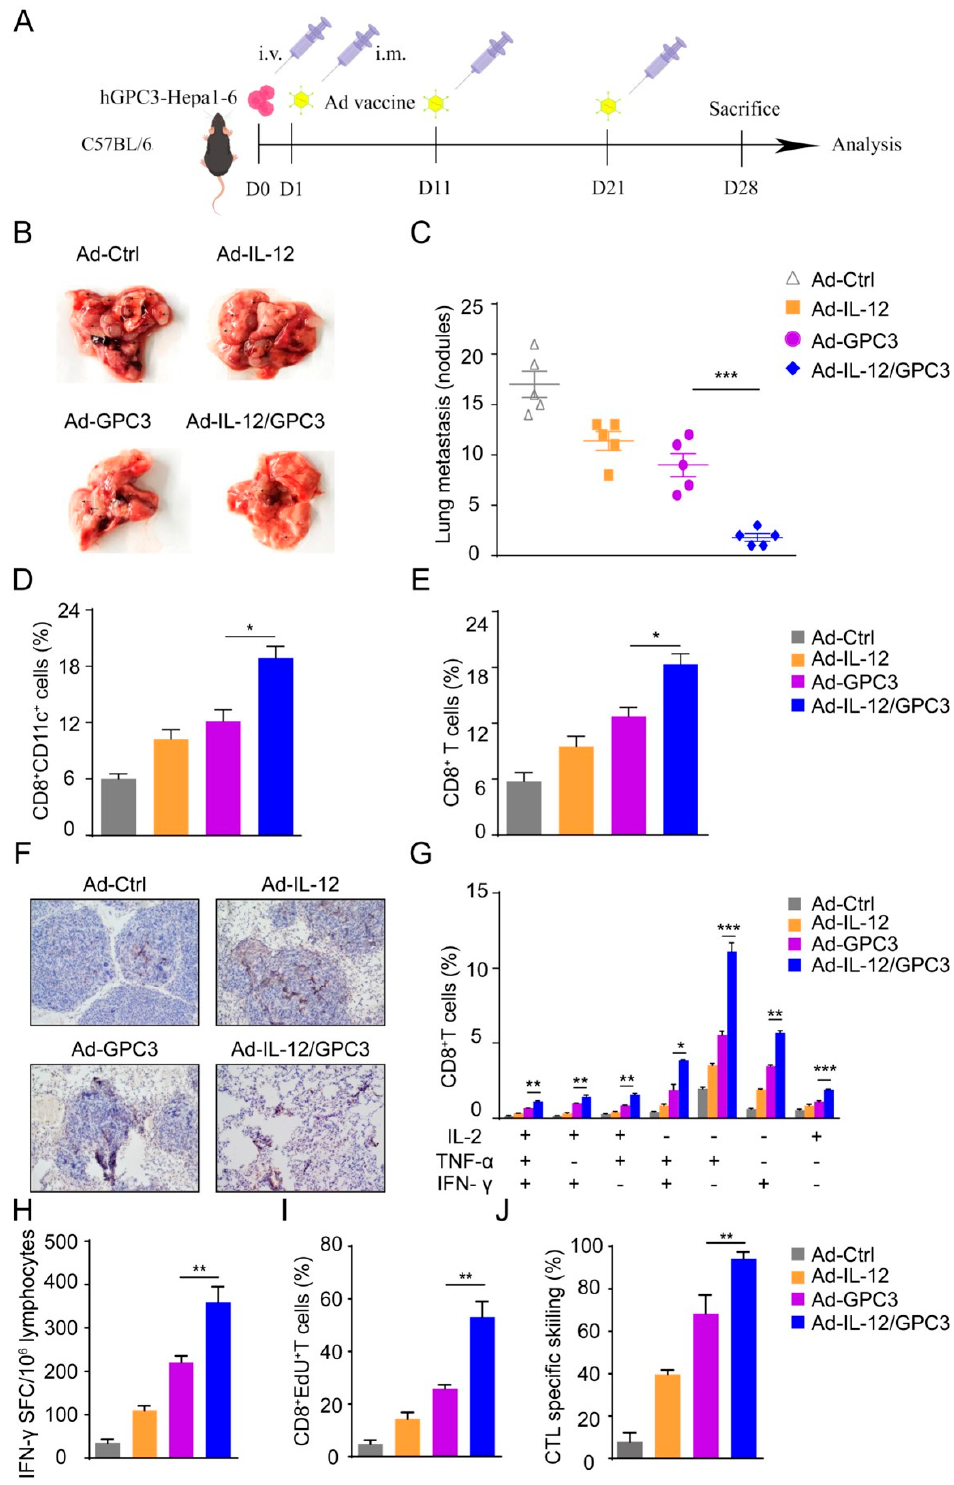
Figure 6. Therapeutic effects of Ad-IL-12/GPC3 vaccine in lung metastasis model. ( A ) Schematic of the timeline of the model; ( B ) the present images of the lung tumor removed from mice; ( C ) the numbers of metastatic nodules were quantified in the lung of the tumor-bearing mice; ( D , E ) mice were sacrificed on day 28 after tumor inoculation, and the frequencies of CD8 + CD11c + cells and CD8 + T cells in the lung tumor tissues of each vaccine groups were analyzed. ( F ) Immunochemistry staining for CD8 + T cells in lung tumor tissues. ( G ) The percentages of TNF- α + IL-2 + CD8 + T